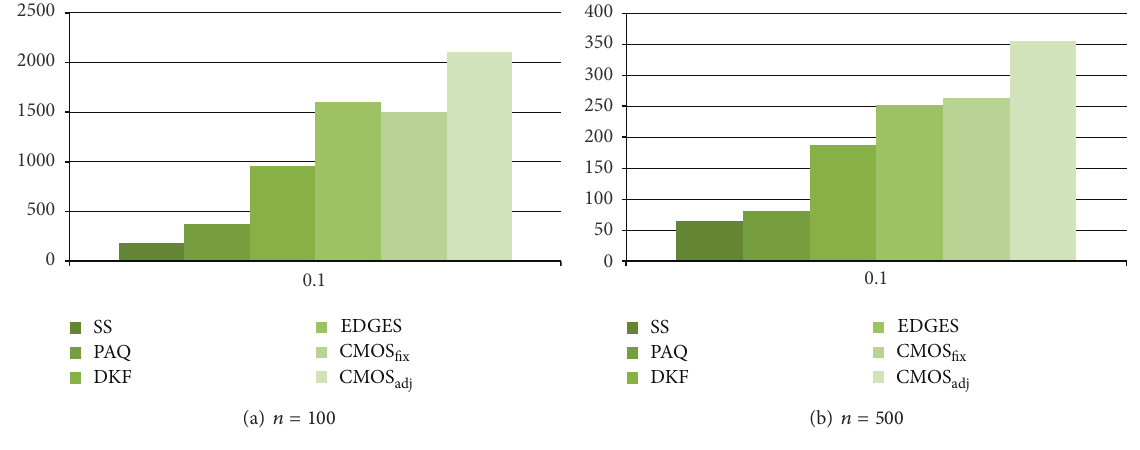
Figure 7: Time to a sensor failure on Wave data.